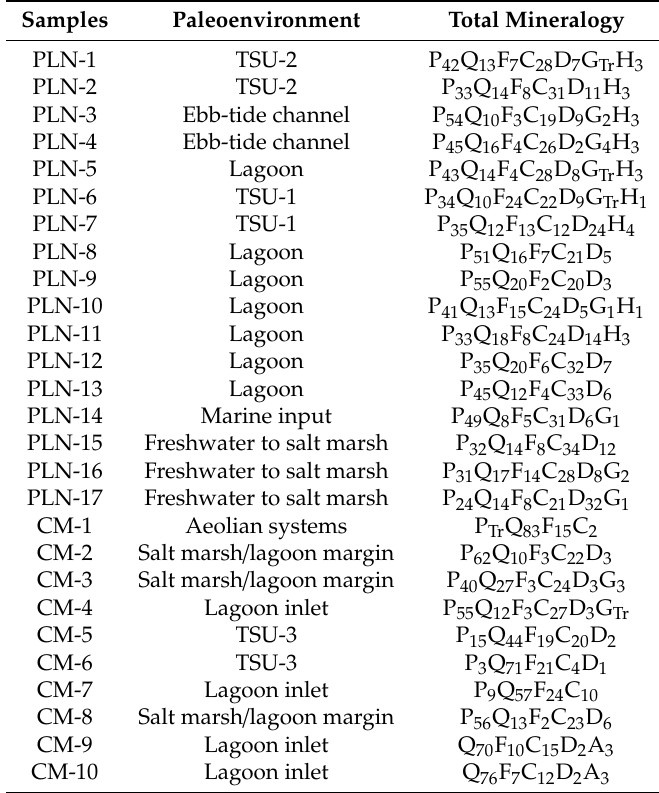
Table 1. Mineralogical database of samples. P: phyllosilicates; Q: quartz; F: feldspars; C: calcite; D: dolomite; H: halite; G: gypsum; A: aragonite; Tr. traces (extracted from [19,20]).